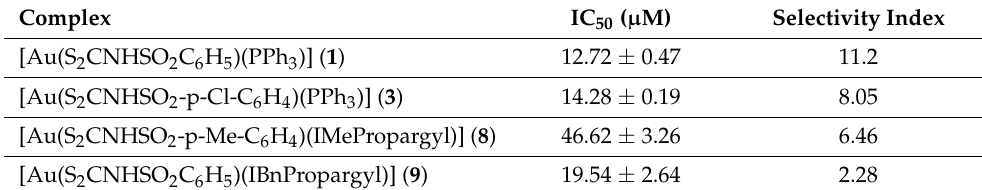
Table 2. IC 50 values and the corresponding selectivity index obtained after treatment for 72 h with dithiocarbamate gold(I) complexes derived from sulfonamides on differentiated Caco-2 cells.